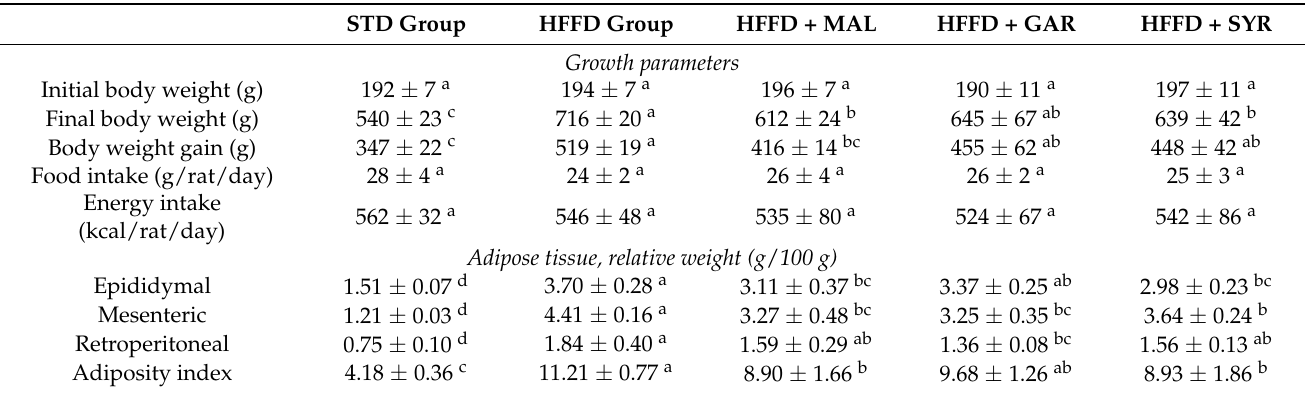
Table 2. Effects of a high-fat high-fructose diet supplemented with different varieties of grape pomace on rat growth, food intake, and adipose tissue